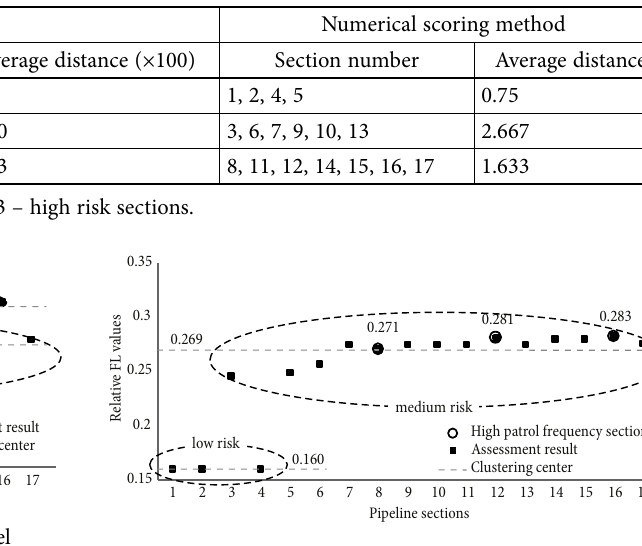
Fig. 13. The assessment results after increasing the patrol